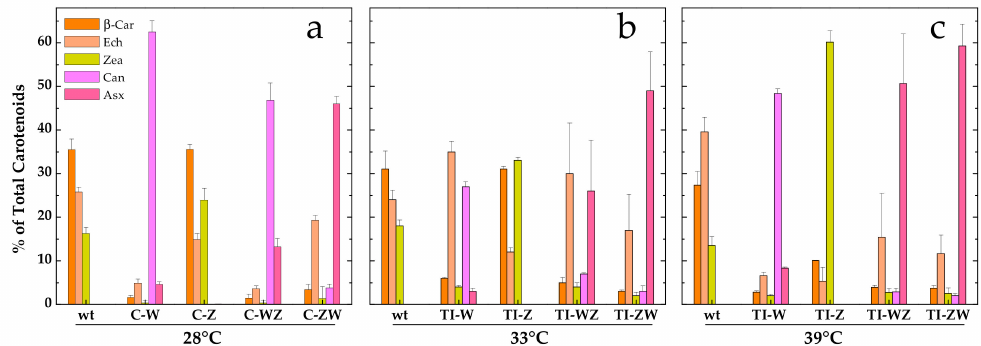
Figure 3. Relative distribution of the main carotenoids in the di ff erent engineered Synechocystis strains with respect to the wild-type. ( a ) Engineered strains constitutively expressing Brevundimonas CrtW and CrtZ (C-W, C-Z, C-WZ and C-ZW) grown at 28 ◦ C. ( b ) and ( c ) Engineered strains expressing Brevundimonas CrtW and CrtZ in a temperature-controlled manner (TI-W, TI-Z, TI-WZ and TI-ZW) after two days induction at ( b ) 33 ◦ C or ( c ) 39 ◦ C. β -car, β -carotene (orange); Ech, echinenone (peach); Zea, zeaxanthin (yellow); Can, canthaxanthin (light magenta); Asx, astaxanthin (pink). wt, wild-type. Error bars indicate